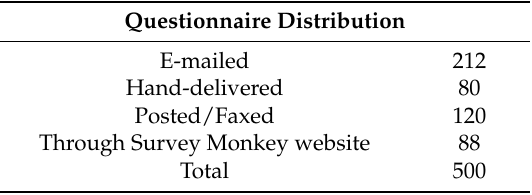
Table 2. Questionnaire distribution (Source: Survey data).